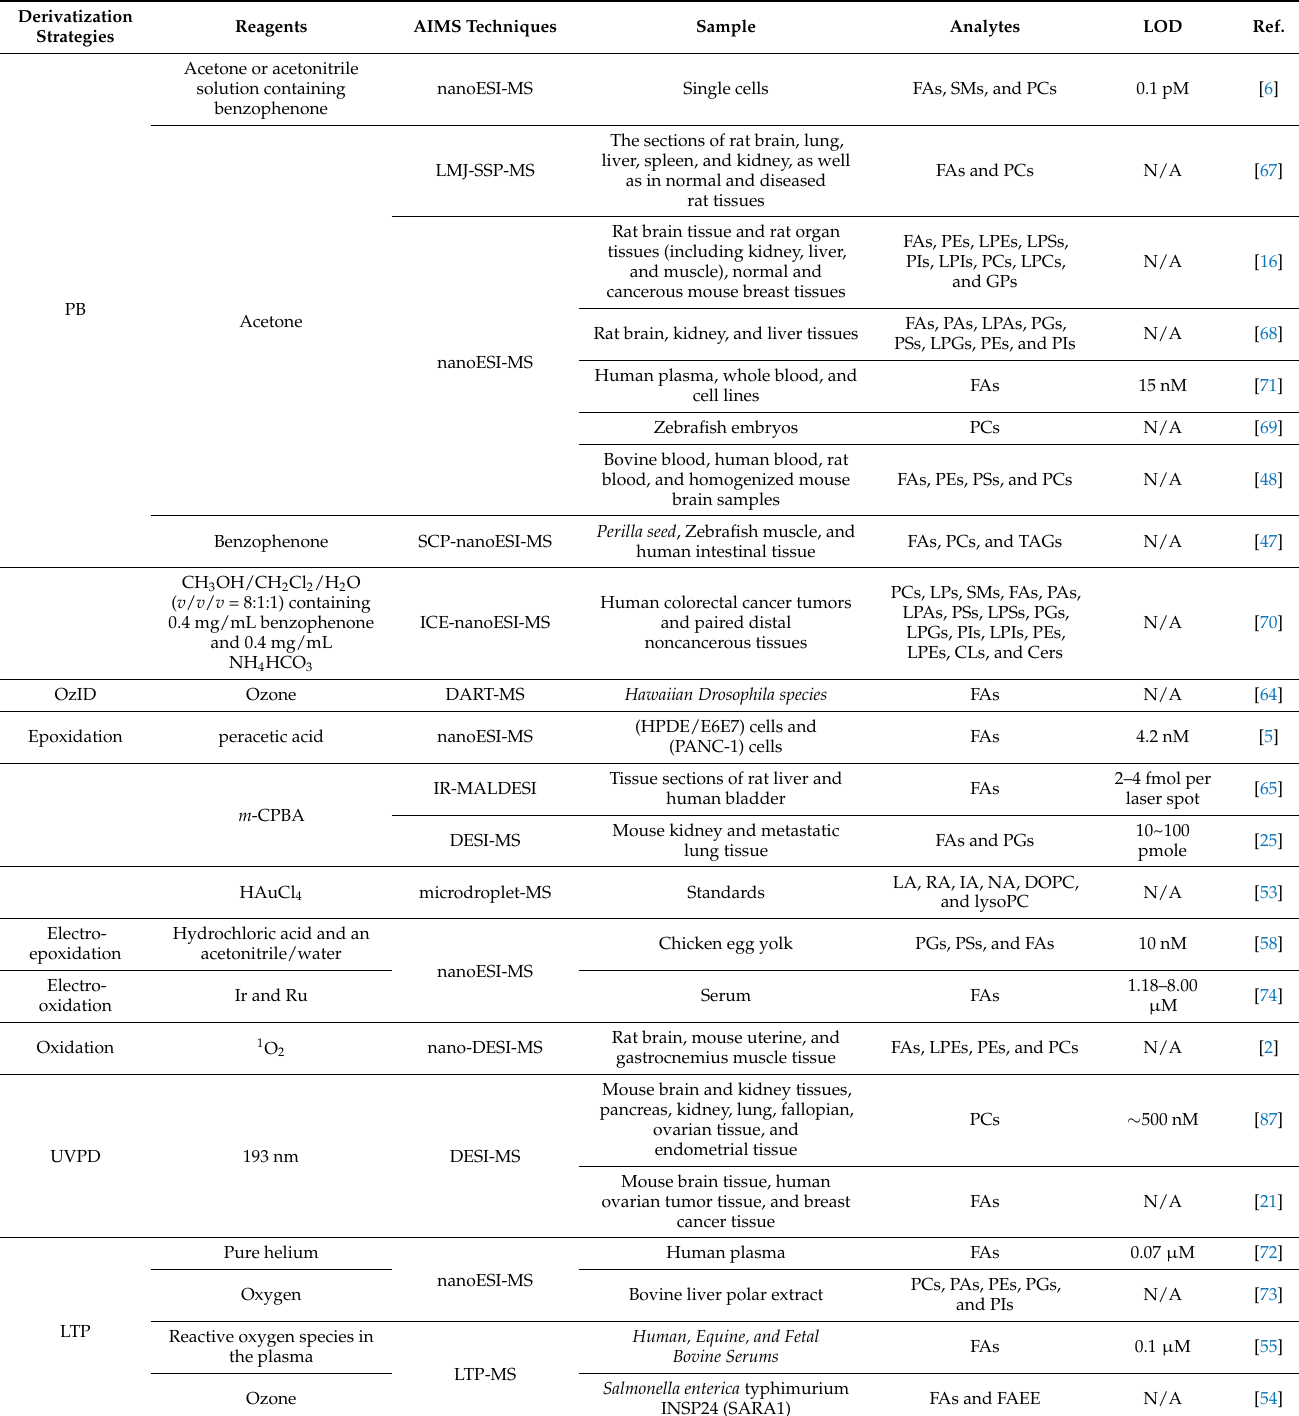
Table 1. The applications of AIMS techniques in elucidation of unsaturated lipids based on different derivatization strategies. Derivatization